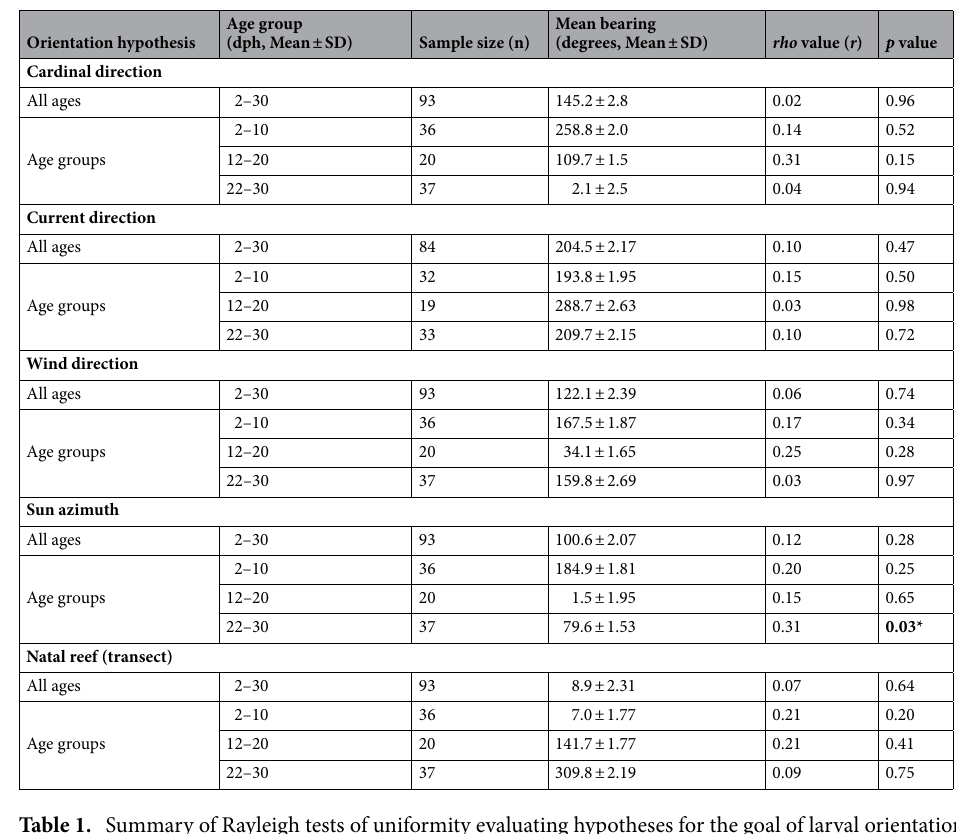
Table 1. Summary of Rayleigh tests of uniformity evaluating hypotheses for the goal of larval orientation behavior among all larvae in the sample [0–30 days post-hatch (dph)], and among ontogenetically relevant age groups (2–10, 12–20, 22–30 dph). *Indicates a significant p value.